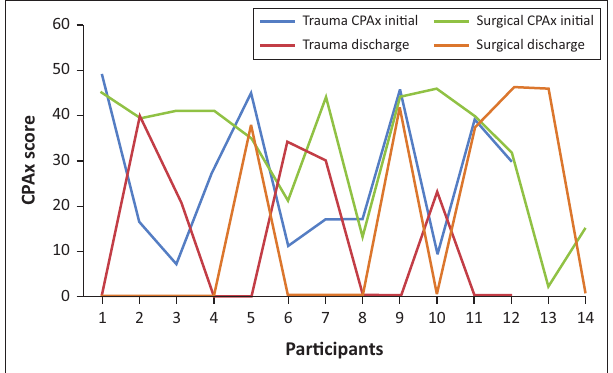
FIGURE 2: Differences in Chelsea critical care physical assessment (CPAx) scores at intensive care unit admission and discharge between participants following surgery or trauma.